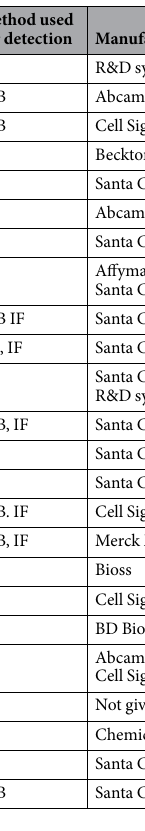
Table 3. List of antibodies used in the references listed in Table 1. IF: immunofluorescence; WB: western blotting. NG: not given.